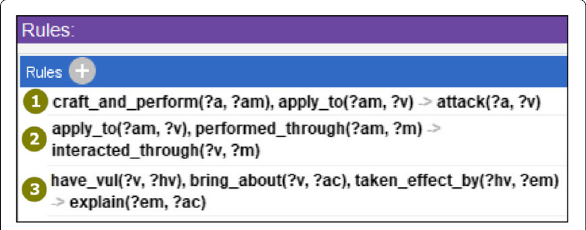
Fig. 15 Rules defined in the ontology